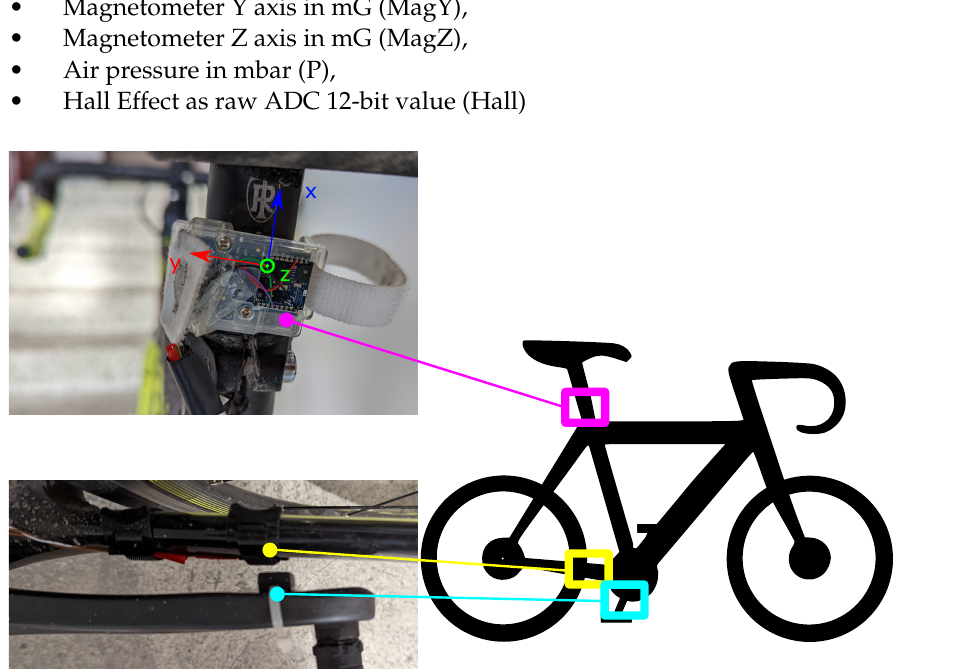
Figure 2. The experimental setup for the measurement of the motion data and the cadence signal. The IMU is fixed to the saddle tube with the given orientation. The Hall-effect sensor is fixed on the frame opposite the permanent magnet on the crank arm.